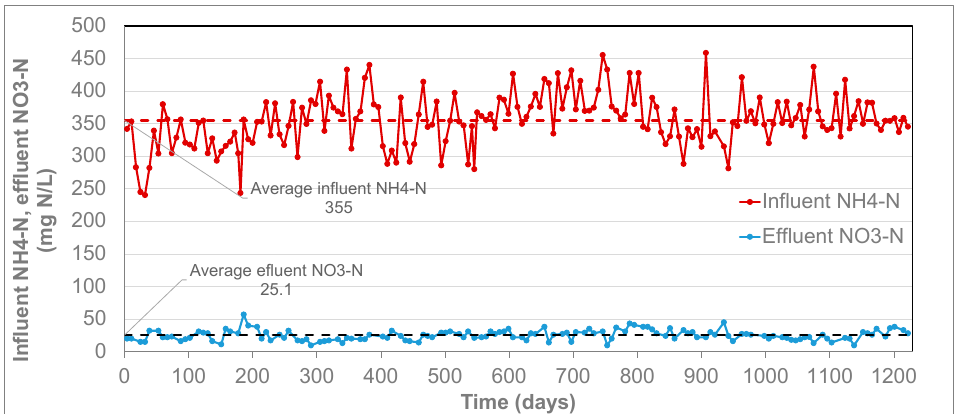
Figure 8. Influent ammonium and effluent nitrate from the Anammox reactor. Each data point rep- resents a single measurement (NO 3 -N) or week average value (NH 4 -N). The horizontal dashed lines show the average values of influent NH 4 -N and effluent NO 3 in the presented period. The average effluent ammonium in this period was 61 mg NH 4 -N/L (not shown in the graph).